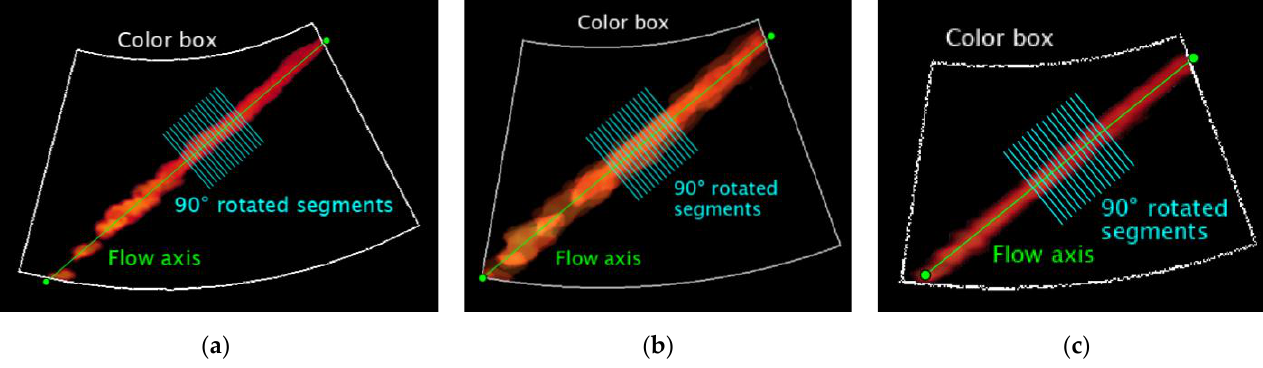
( b ) ( c ) Figure 7. Example of reconstructed velocity profile associated with a single segment drawn on the i -th average image for ( a ) system one, ( b ) system two and ( c ) system three equipped with convex array probes in configuration B at 7.0 mL·s −1 . The method specifications assumed in this study are listed in Table 6. Table 6. Variables setting for both AMVS and VeMeA parameters estimation. Variable